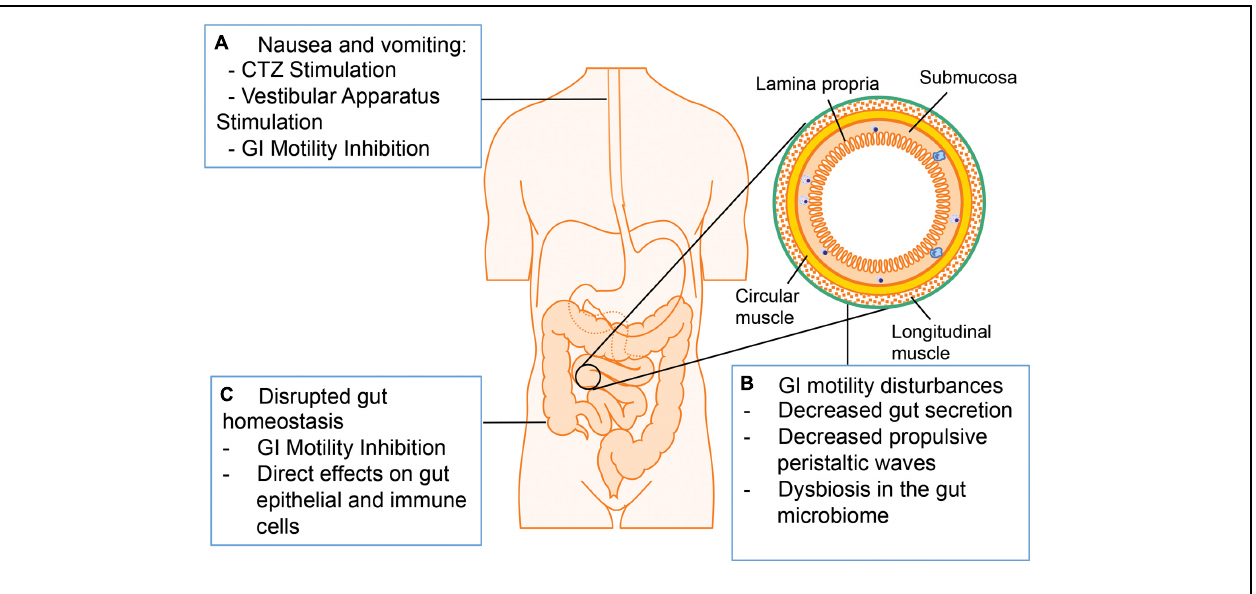
FIGURE 4 | Adverse GI effects associated with opioid administration. (A) Opioid treatment induces nausea and vomiting via chemoreceptor trigger zone (CTZ) stimulation, vestibular stimulation, and GI motility inhibition. (B) Opioid treatment induces GI motility disturbances by